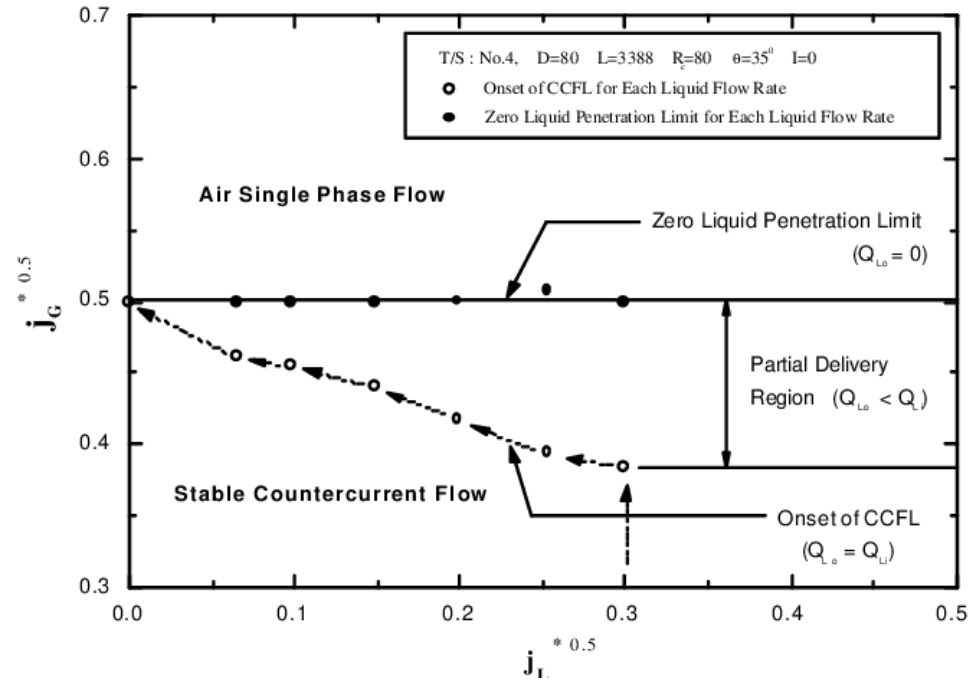
Figure 2. The typical CCFL curve obtained with a hot leg model by using Wallis parameters (Kang et al. [11]).